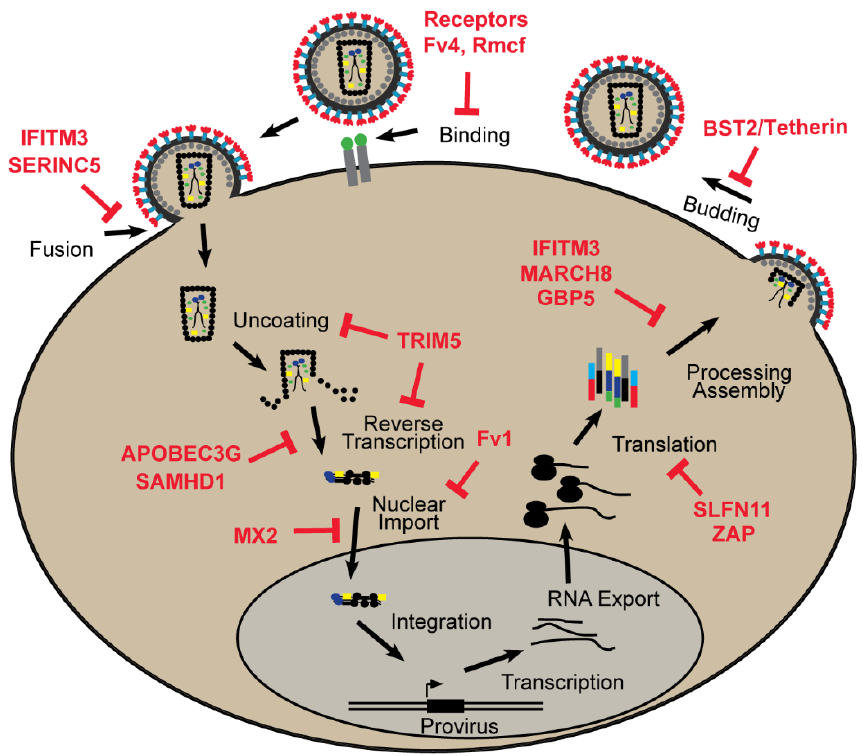
Figure 1. Restriction factors block specific stages of the retroviral life cycle.